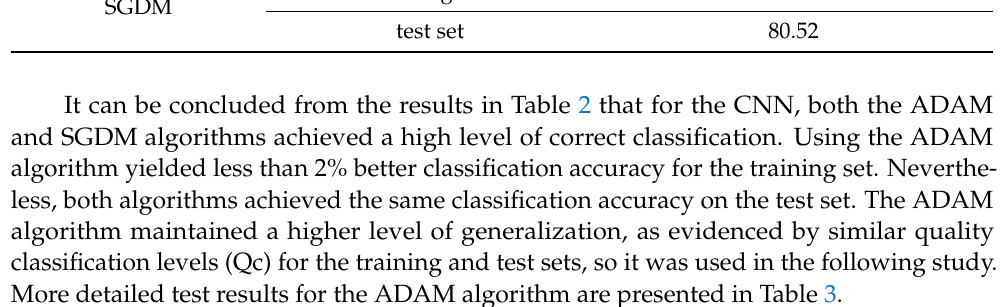
Table 2. CNN quality classification levels.